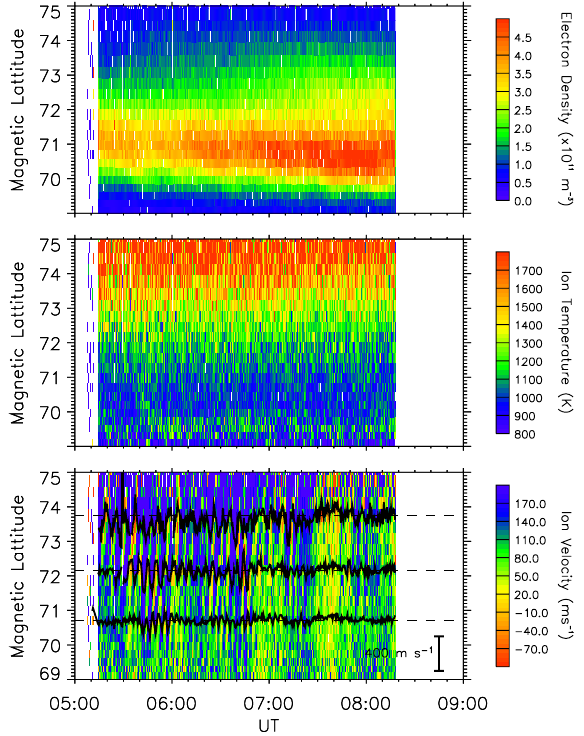
Fig. 10. Electron density, ion temperature and ion line-of-sight ve- locity measurements from low elevation northward pointing beam of the EISCAT VHF radar located in Tromsø. Data are presented as a function of magnetic latitude and universal time with each param- eter colour-coded according to the scales shown on the right hand side. Line-of-sight velocity time-series extracted at 70.7 ◦ , 72.2 ◦ and 73.8 ◦ magnetic latitude are also